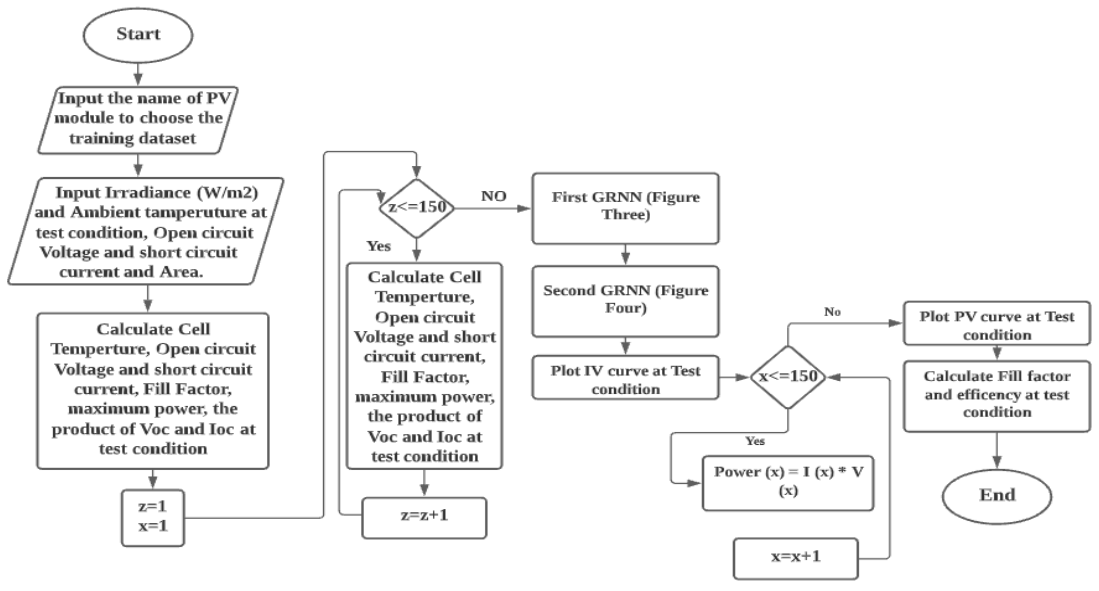
Figure 6. Flowchart of the proposed model process.